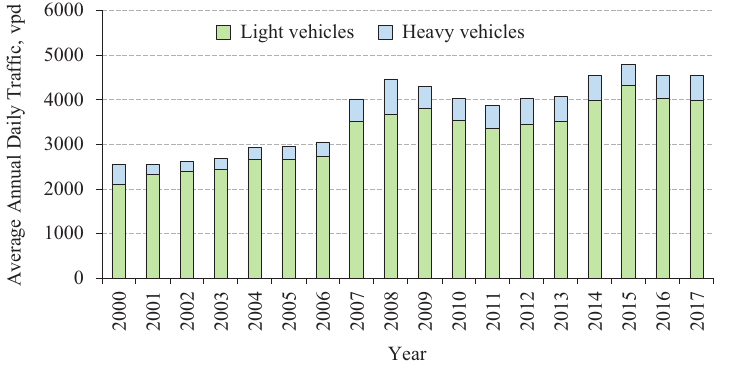
Figure 1. Average Annual Daily Traffic on the road No. A16 from 2000 to 2017